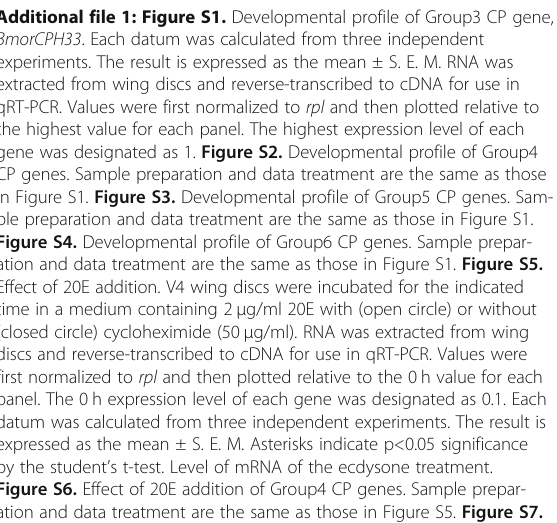
Additional file 1: Figure S1. Developmental profile of Group3 CP gene, BmorCPH33 . Each datum was calculated from three independent experiments. The result is expressed as the mean ± S. E. M. RNA was extracted from wing discs and reverse-transcribed to cDNA for use in qRT-PCR. Values were first normalized to rpl and then plotted relative to the highest value for each panel. The highest expression level of each gene was designated as 1. Figure S2. Developmental profile of Group4 CP genes. Sample preparation and data treatment are the same as those in Figure S1. Figure S3. Developmental profile of Group5 CP genes. Sam- ple preparation and data treatment are the same as those in Figure S1. Figure S4. Developmental profile of Group6 CP genes. Sample prepar- ation and data treatment are the same as those in Figure S1. Figure S5. Effect of 20E addition. V4 wing discs were incubated for the indicated time in a medium containing 2 μ g/ml 20E with (open circle) or without (closed circle) cycloheximide (50 μ g/ml). RNA was extracted from wing discs and reverse-transcribed to cDNA for use in qRT-PCR. Values were first normalized to rpl and then plotted relative to the 0 h value for each panel. The 0 h expression level of each gene was designated as 0.1. Each datum was calculated from three independent experiments. The result is expressed as the mean ± S. E. M. Asterisks indicate p<0.05 significance by the student ’ s t-test. Level of mRNA of the ecdysone treatment. Figure S6. Effect of 20E addition of Group4 CP genes. Sample prepar- ation and data treatment are the same as those in Figure S5. Figure S7. Effect of 20E addition of Group5 CP genes. Sample preparation and data treatment are the same as those in Figure S5. Figure S8. Developmental profile of Group5 CP genes that were up-regulated by the 20E addition. Sample preparation and data treatment are the same as those in Figure S5. Figure S9. Developmental profile of Group5 CP genes that were not up-regulated by the 20E addition. Sample preparation and data treatment are the same as those in Figure S5. Figure S10. Effect of ecdysone pulse treatment of Group3 gene. Wing discs of the W2 stage were incubated 12h in a medium containing 2 μ g/ml 20E and then transferred to a hormone-free medium with (open circle) or without cycloheximide (50 μ g/ml) for the indicated time. RNA was extracted from wing discs and reverse-transcribed to cDNA for use in qRT-PCR. Values were first normalized to rpl and then plotted relative to the highest value for each panel. The highest expression level of each gene was designated as 1. Level of mRNA after ecdysone pulse treatment. Each datum was calculated from three independent experiments. The result is expressed as the mean ± S. E. M. Asterisks indicate p<0.05 significance by the student ’ s t-test. Level of mRNA of the ecdysone treatment. Figure S11. Effect of ecdysone pulse treatment of Group4 gene. Sample preparation and data treatment are the same as those in Figure S10. Figure S12. Effect of ecdysone pulse treatment of Group5 gene. Sample preparation and data treatment are the same as those in Figure S10. Figure S13. Effect of ecdysone pulse treatment of Group6 gene. Sample preparation and data treatment are the same as those in Figure S10. Additional file 2: Table S1. List of primers. Additional file 3: Table S2. Groups of CP genes and regulating